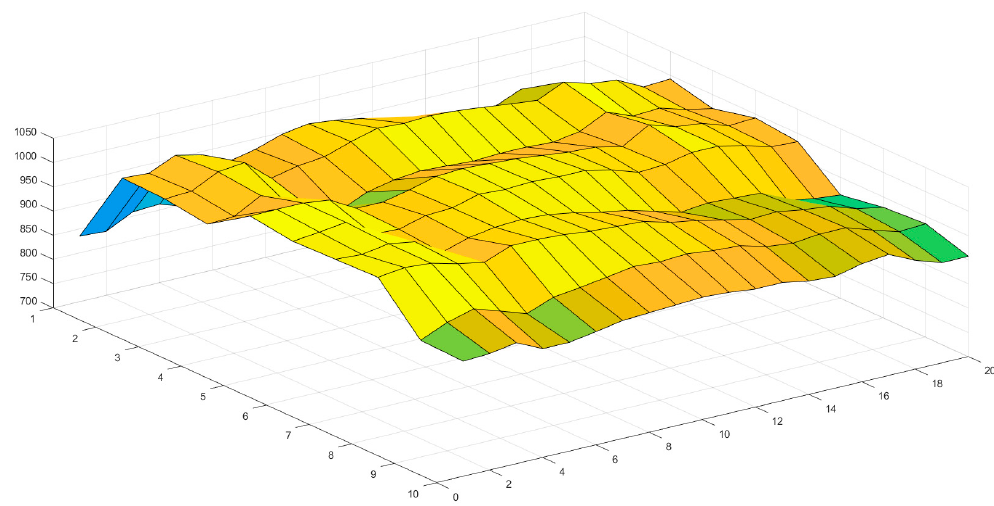
Figure 8. Spatial distribution of irradiation values on the test surface (W/m 2 ).